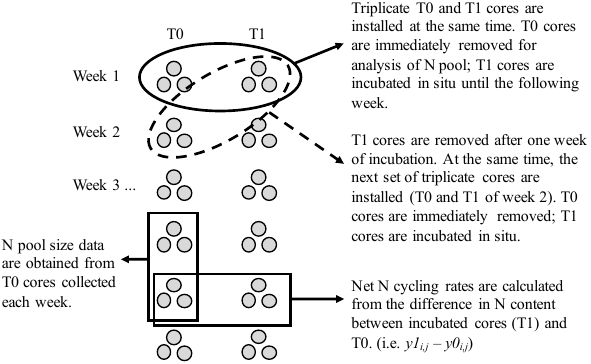
Figure 1. Schematic illustrating the sampling design across 9 weeks during the growing season. Each week, two sets of three replicate cores were installed at each study site. One set was immediately removed for pool size estimates; the second set was incubated in situ for 1 week to estimate net cycling